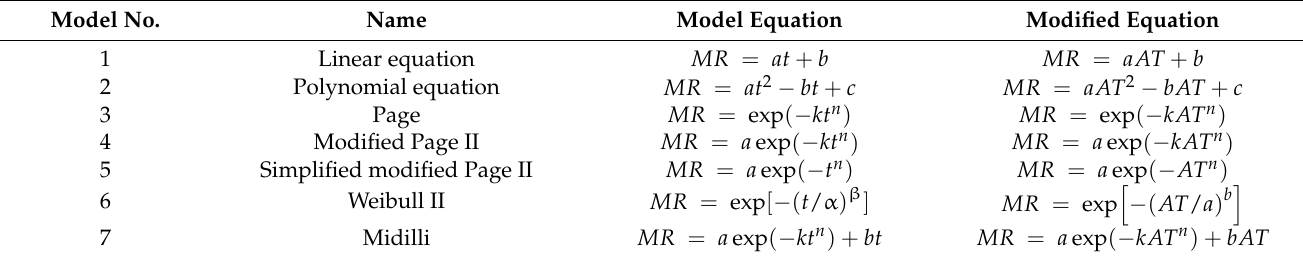
Table 4. Several commonly used mathematical models.